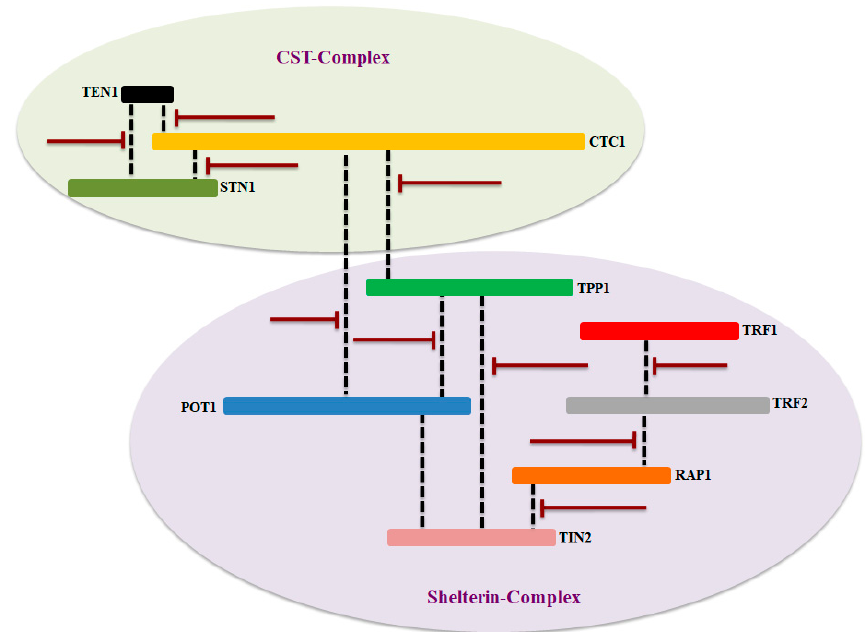
Figure 6. Proposed key target site in CST and shelterin complex that can be targeted for